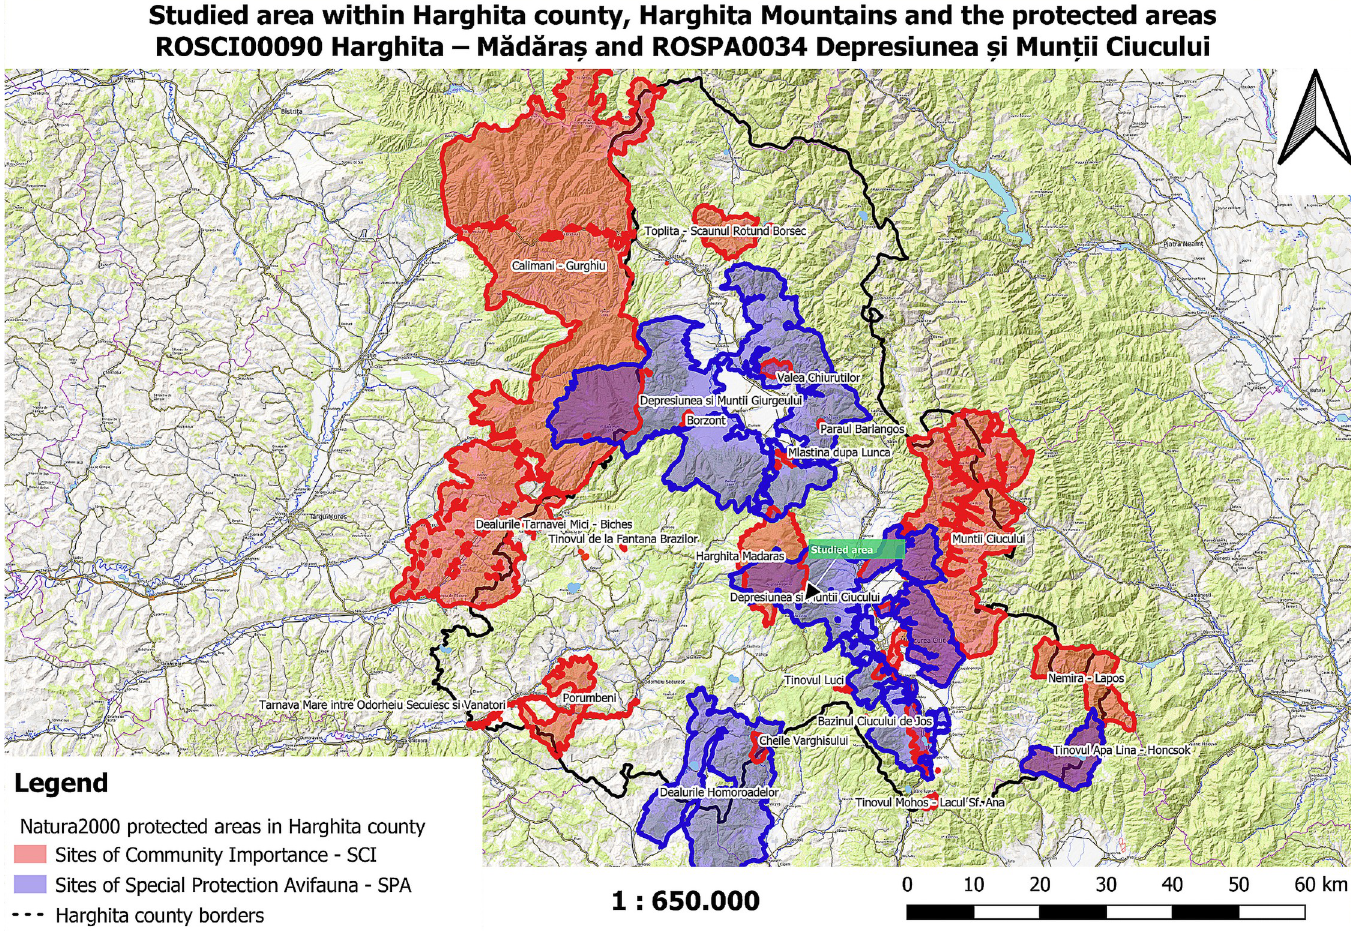
Fig 1. The map of the studied area within Harghita county, Harghita Mountains and the protected areas ROSCI00090 Harghita–M ă d ă ra ş and ROSPA0034 Depresiunea ş i Mun ţ ii Ciucului (map used by permission of National Agency for Protected Areas Harghita Territorial Service, Romania).